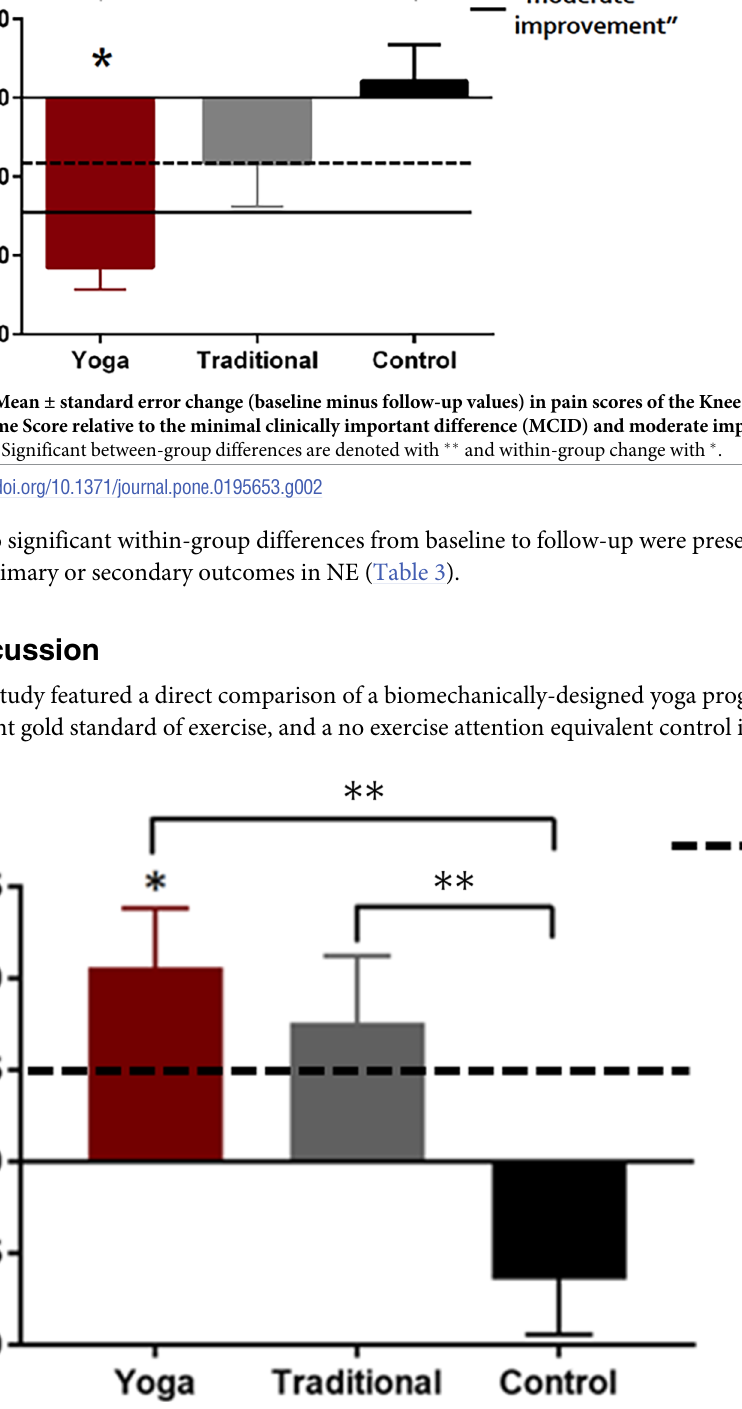
Fig 3. Self-reported physical function measured using the Lower Extremity Functional Scale. Data are presented as mean ± standard error change (follow-up minus baseline values) in scores relative to the minimal clinically important difference (MCID) values. Significant between-group differences are denoted with (cid:3)(cid:3) and within-group change with (cid:3) .